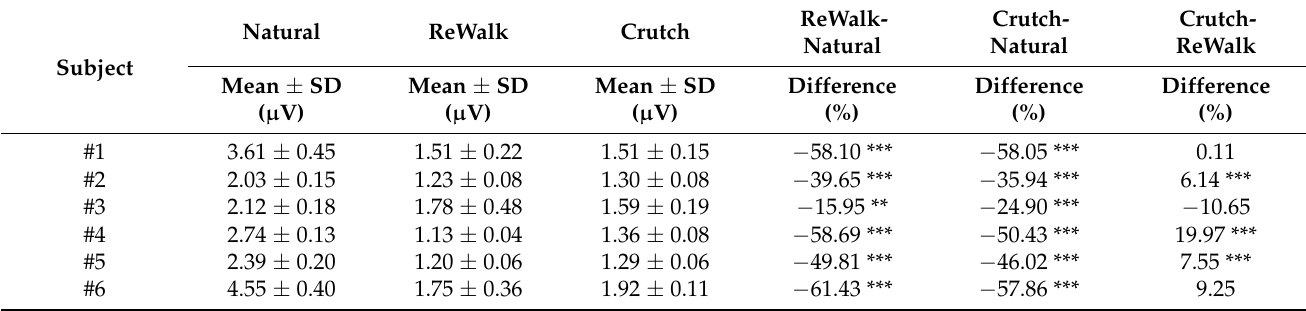
Table 2. Comparison of mean RF EMG WL during the WA phase.